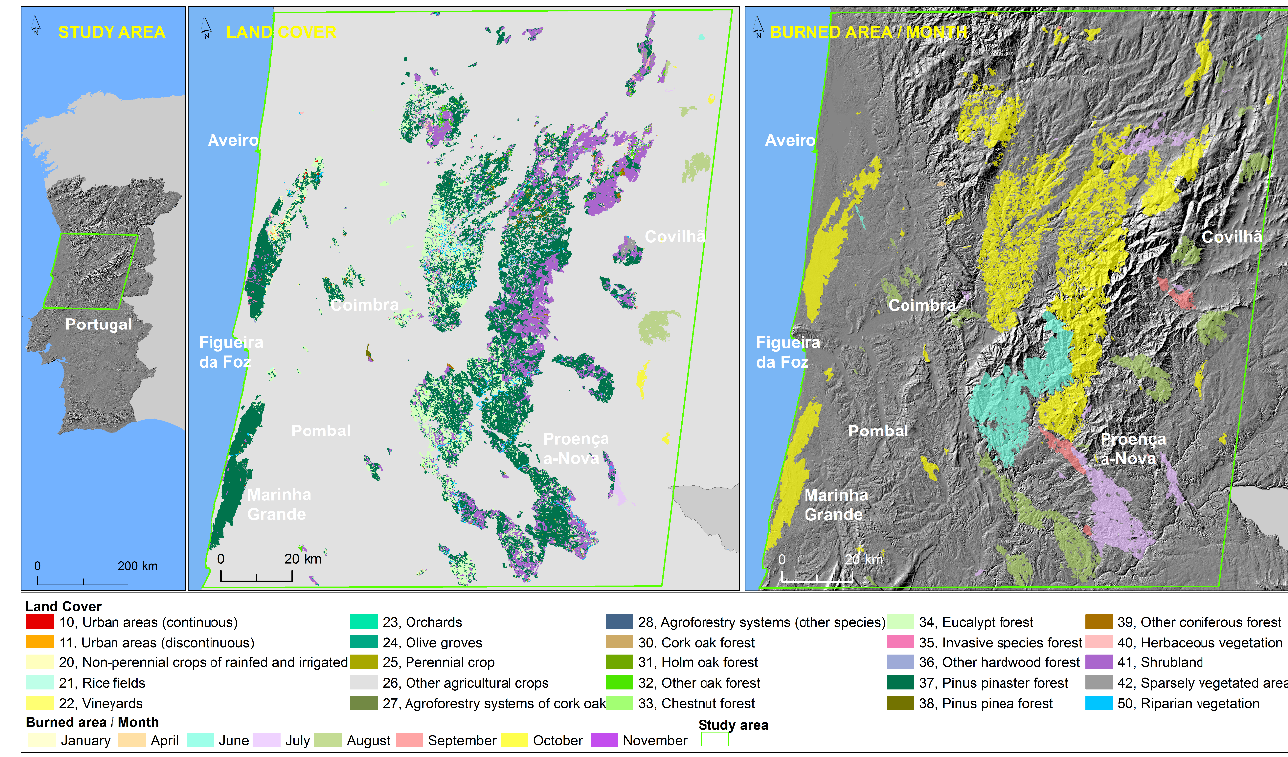
Figure 1. Study area (center of Portugal): land cover and burned area by month of 2017.